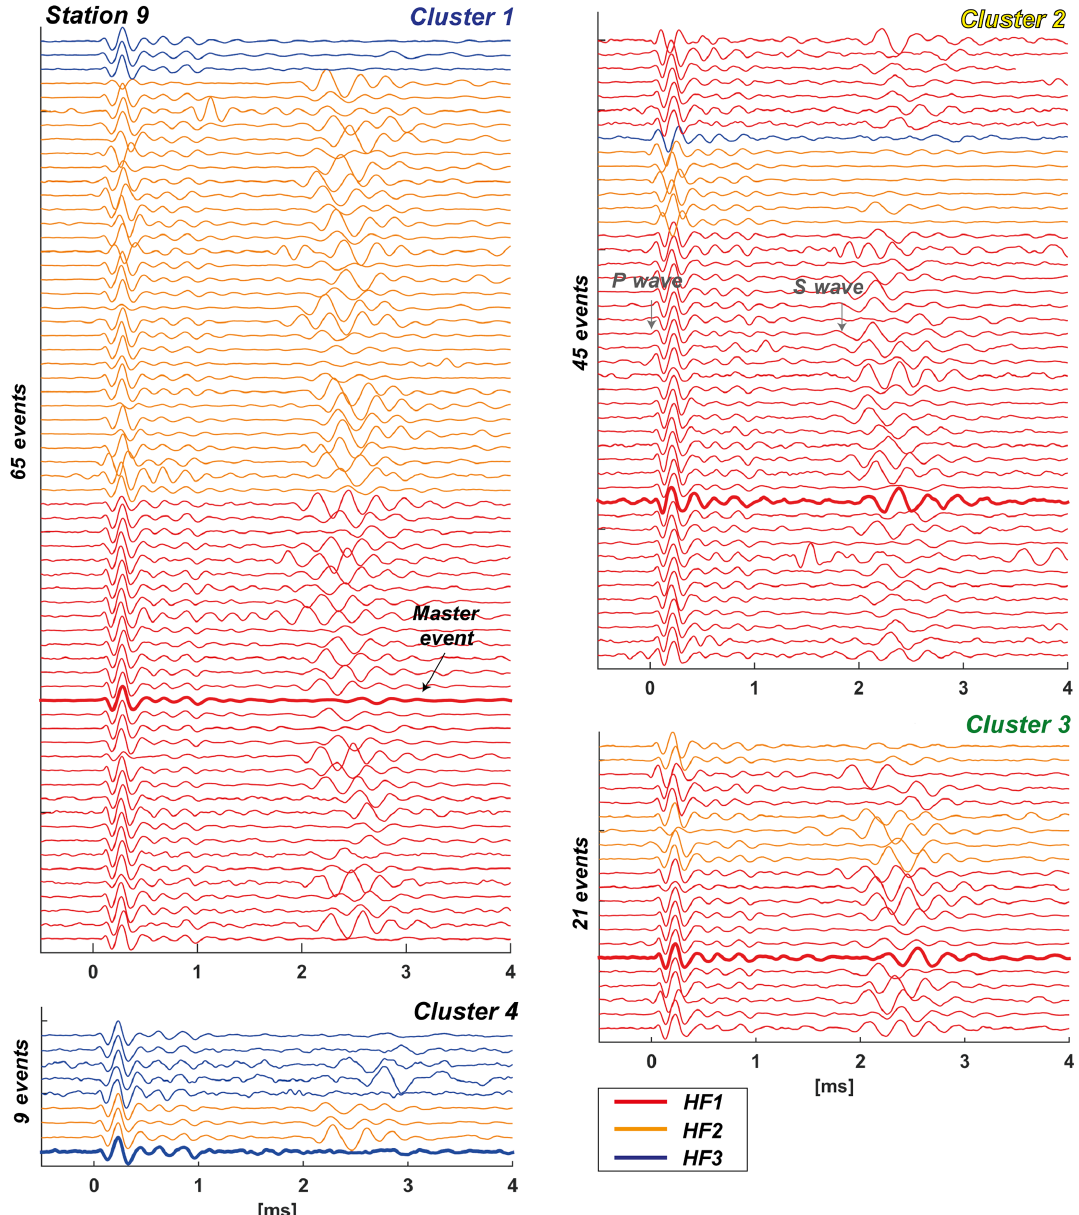
Figure 8. Selected waveform events for station S9 and clusters 1–4. Most clusters contain events from several hydraulic fracturing